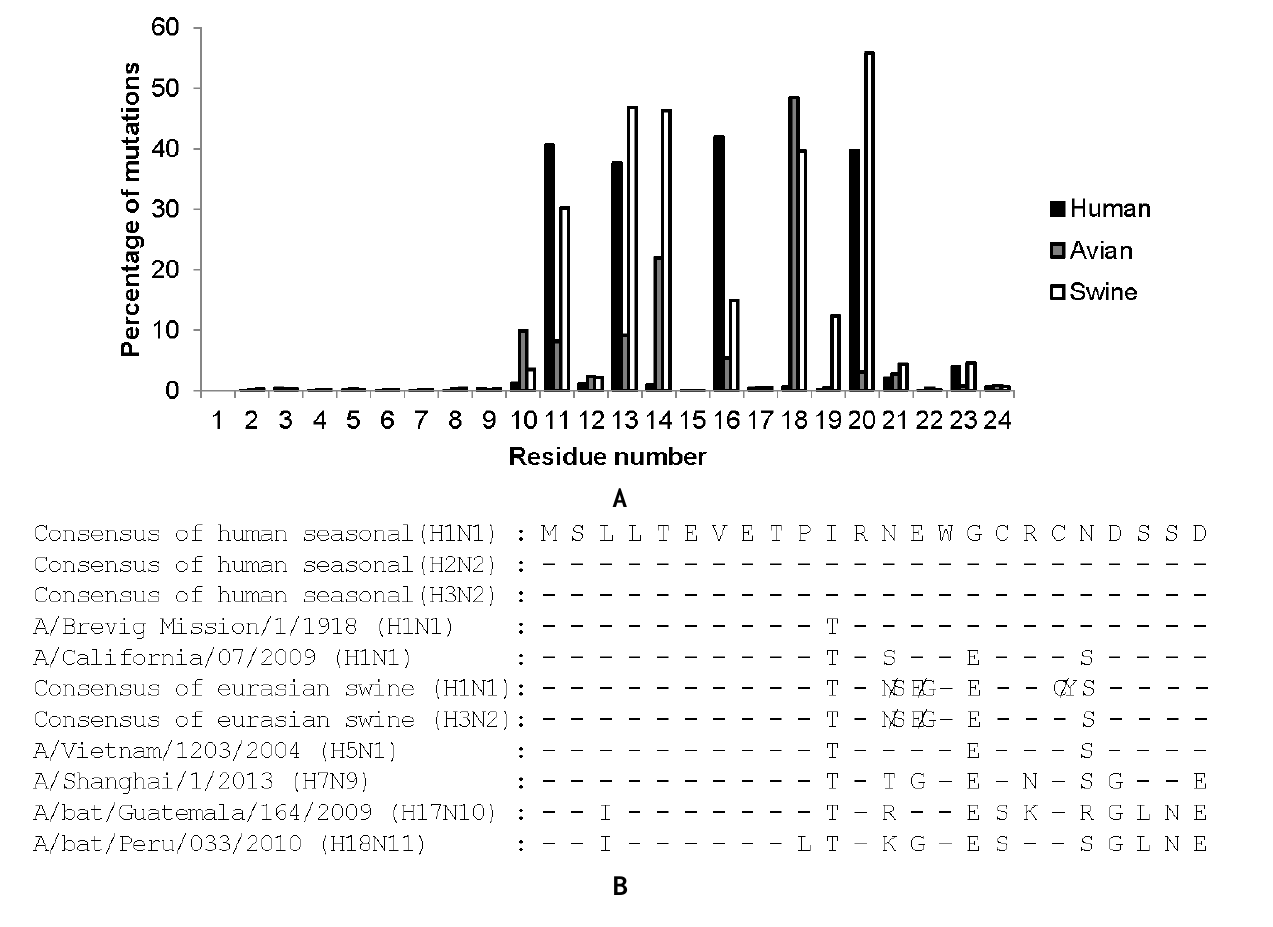
Figure 1. Mutation frequency of amino acids in human, avian, and swine consensus